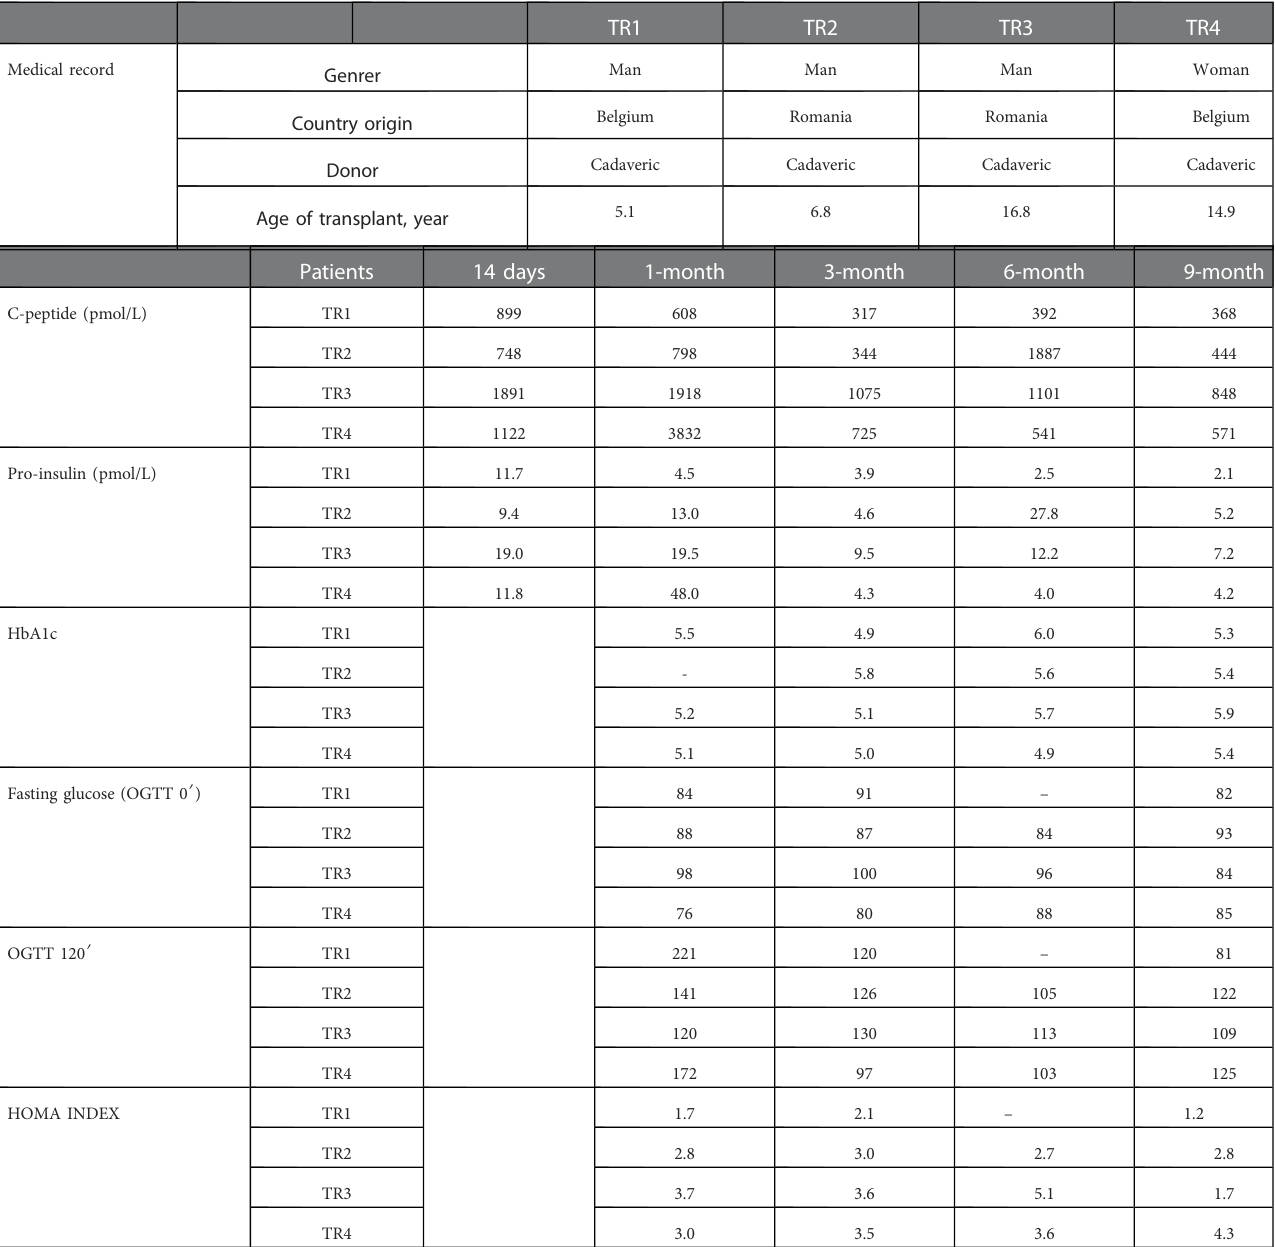
TABLE 8 Glycemic pro fi le data of RT cohort